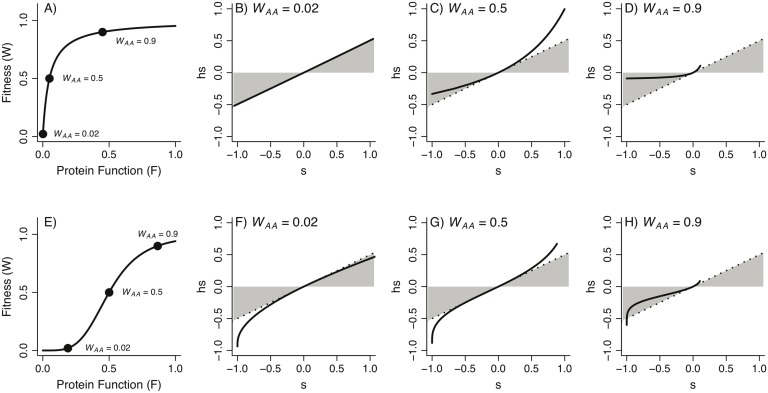
The relationship between protein function and fitness alters the complementation of mutations affecting protein function.Regions where mutations have recessive effects (0< h<0.5) are shown in gray and additive effects (h = 0.5) are shown as a dashed line. The Physiological Theory predicts that (A) the hyperbolic relationship between protein function and fitness results in additive mutation effects only when the wildtype fitness is near zero (B). At moderate (C) and high (D) wildtype fitnesses, deleterious and beneficial mutations are predicted to be recessive and dominant, respectively. The sigmoidal fitness function predicted for proteins that display cooperative binding (E) causes a stronger dependence of dominance coefficients on wildtype fitness. For instance, the sigmoidal relationship yields recessive beneficial mutations when wildtype fitness is low (F), but dominant beneficial mutations when wildtype fitness is moderate (G) and high (H).